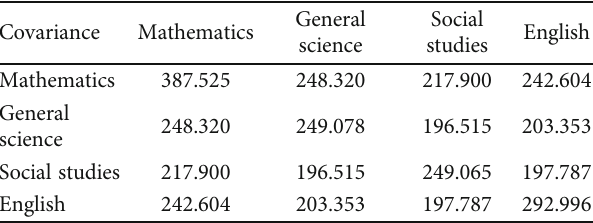
Table 3: The covariance for total nontribal students.